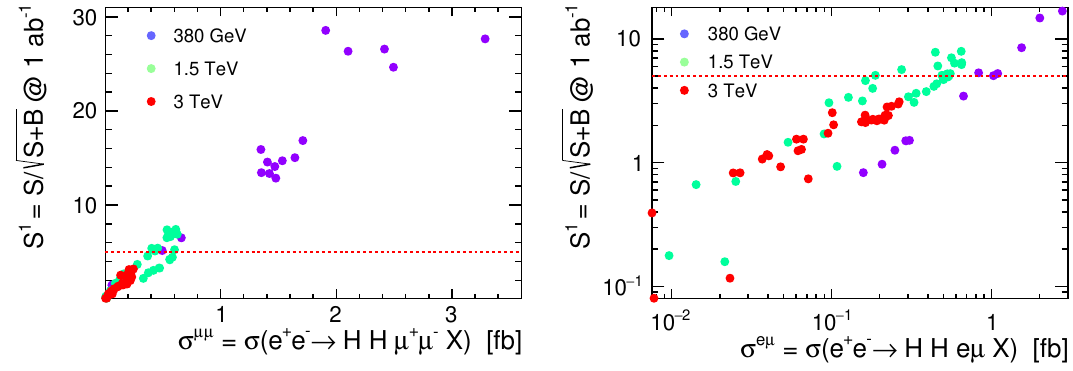
Figure 11 . Signi(cid:12)cance of the deviations from the Standard Model predictions expected at di(cid:11)erent CLIC running stages, assuming the same integrated luminosity of 1 ab (cid:0) 1 , as a function of the signal cross-section in the considered channel, for: (left) events with two muons in the (cid:12)nal state ( (cid:22) + (cid:22) (cid:0) ) and (right) events with electron-muon pair production ( e + (cid:22) (cid:0) or e (cid:0) (cid:22) + ), for the IDM benchmark points in tables 1 and